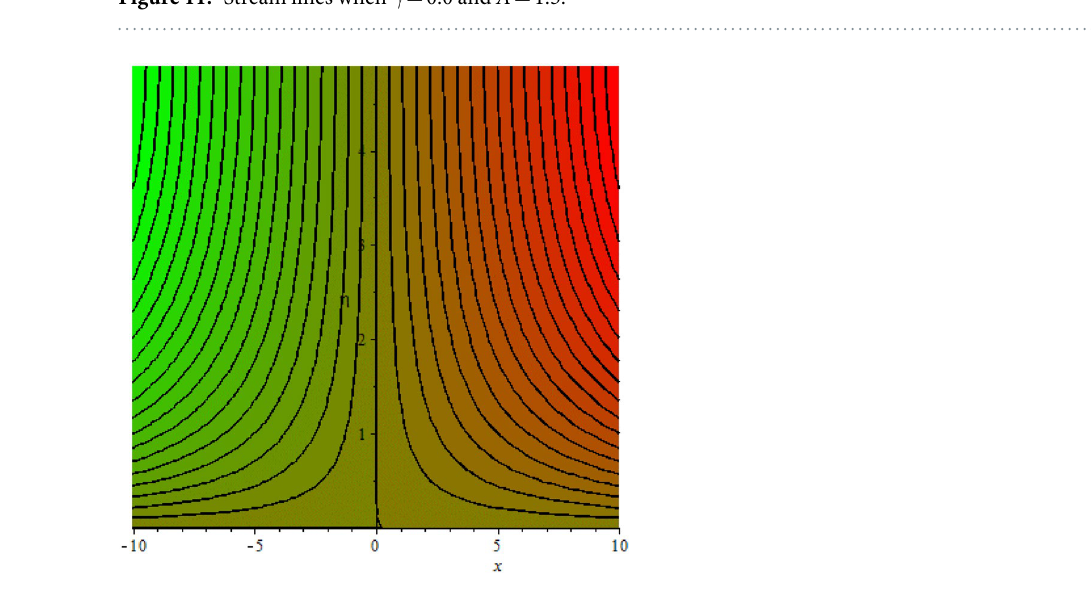
Figure 12. Stream lines when γ = 0.5 and A = 1.5.